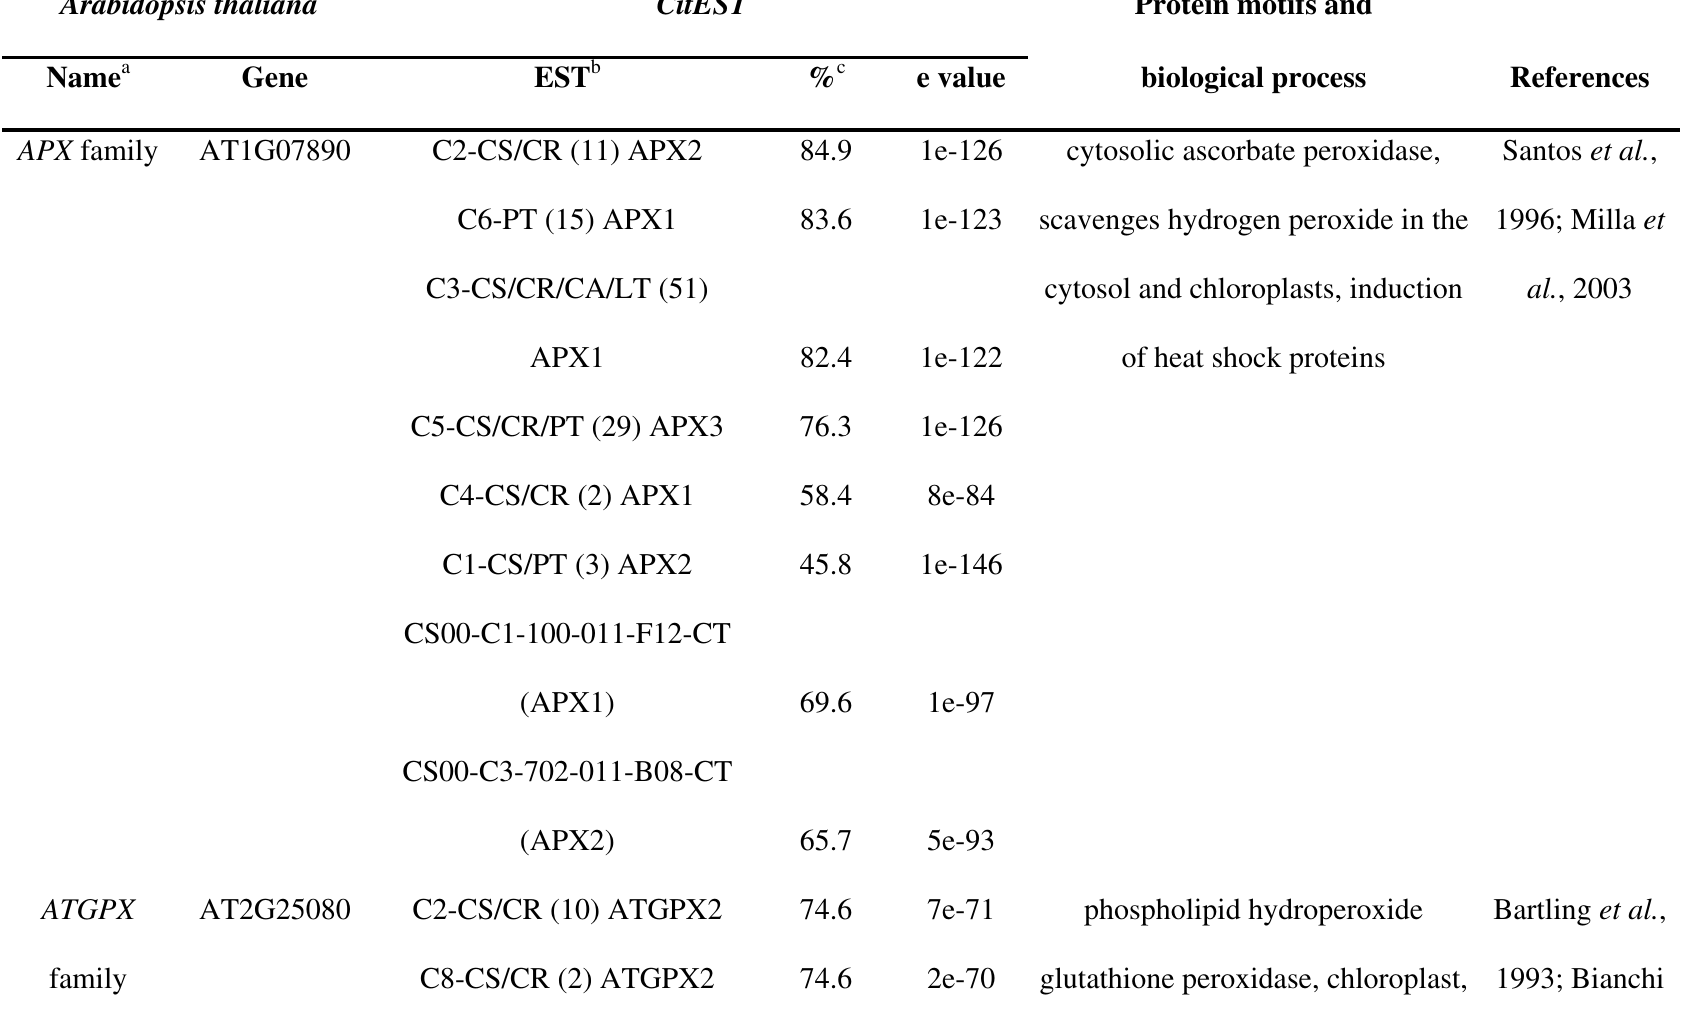
Table S8 – Citrus ESTs with homology to peroxidase protein families from Arabidopsis thaliana